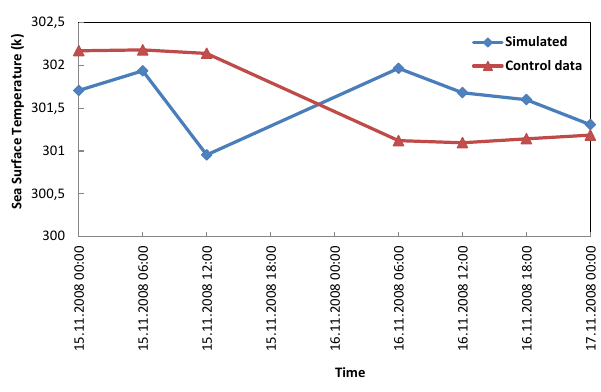
Figure 3. Comparison of best model performance (simulation 6) Fig. 3 Comparison of best model performance (simulation 6) with control data, for six-hourly 2 with control data, for 6-hourly SST prediction during typhoon SST prediction during typhoon Noul 3